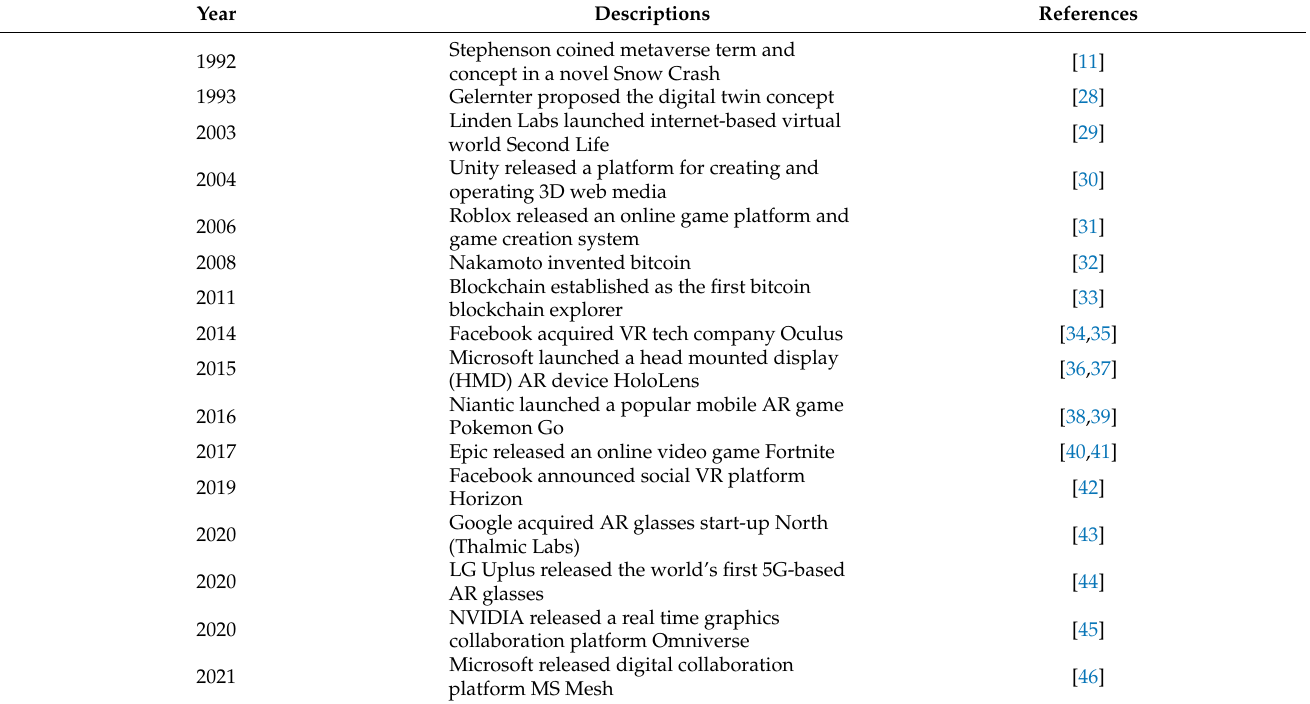
Table 1. Metaverse timeline with its related product and